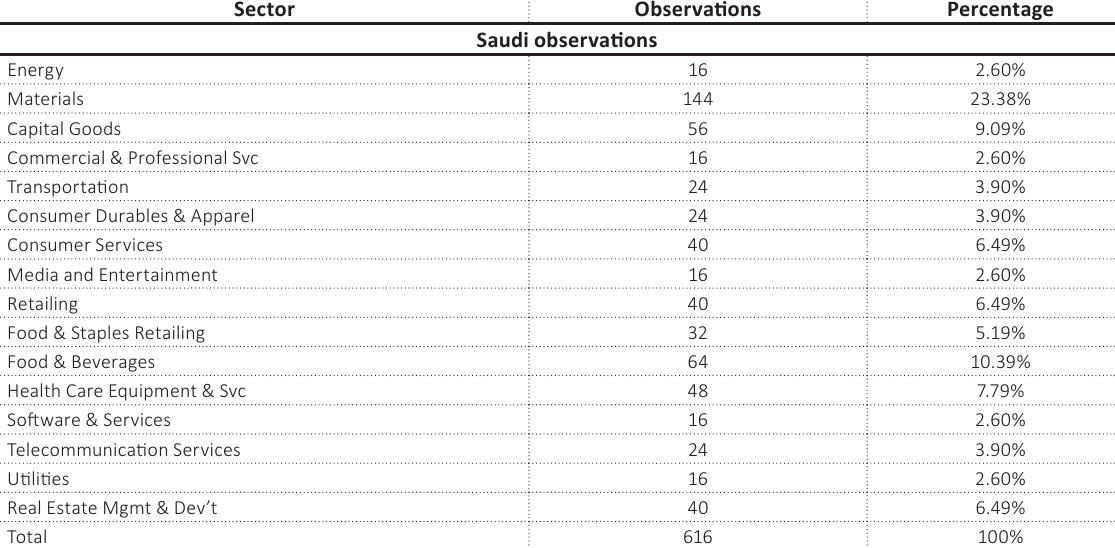
Table 1 (cont.). Distribution of the